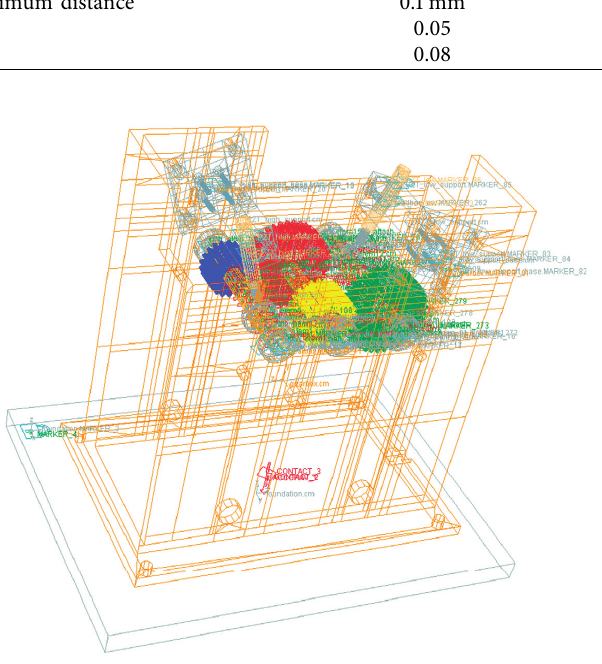
Figure 4: Overall diagram of the ADAMS virtual